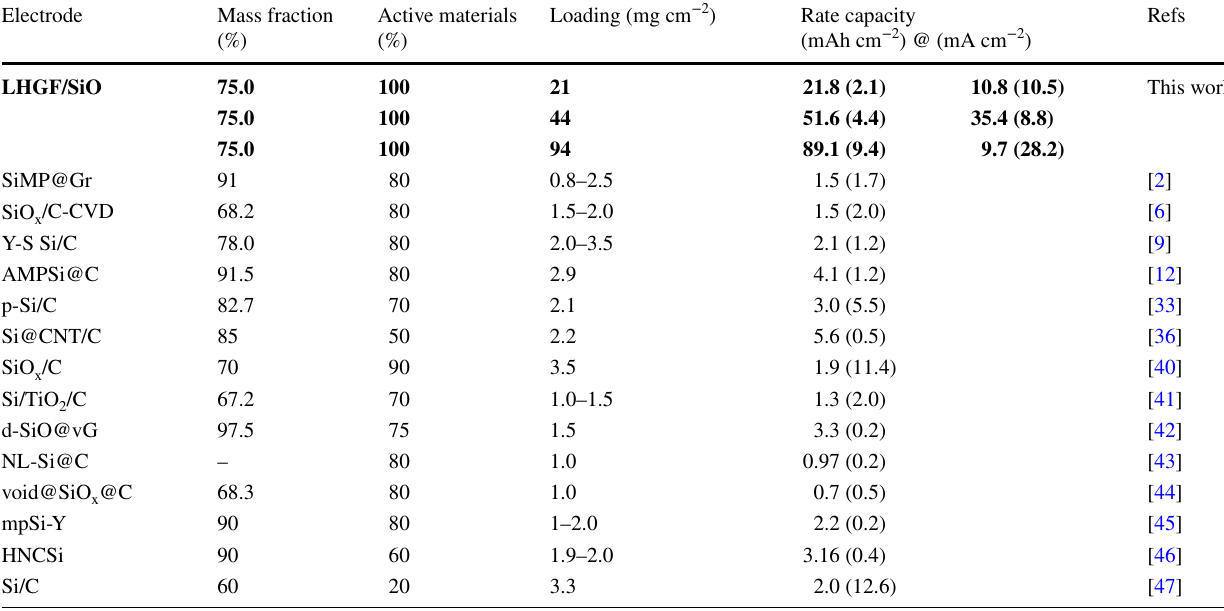
Table 1 Comparison of LHGF/SiO composite electrodes with other silicon-based electrodes